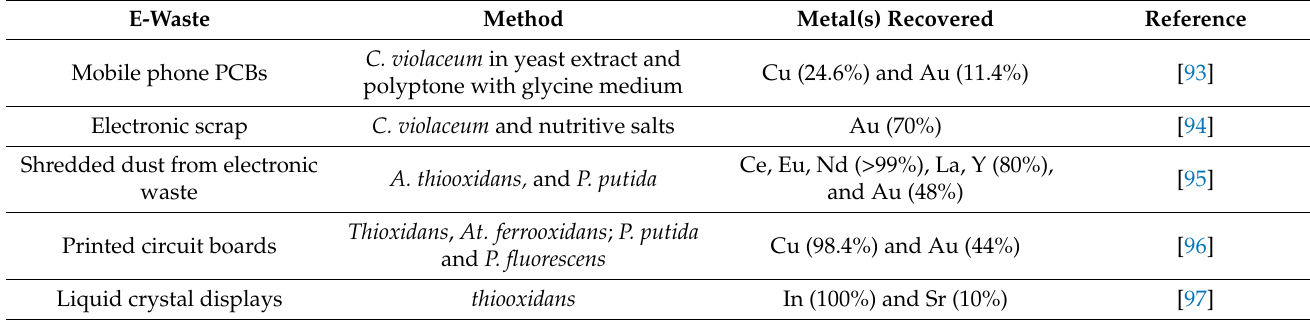
Table 8. A summary of metal recovery from e-waste utilizing bioleaching processes. E-Waste Method Metal(s) Recovered